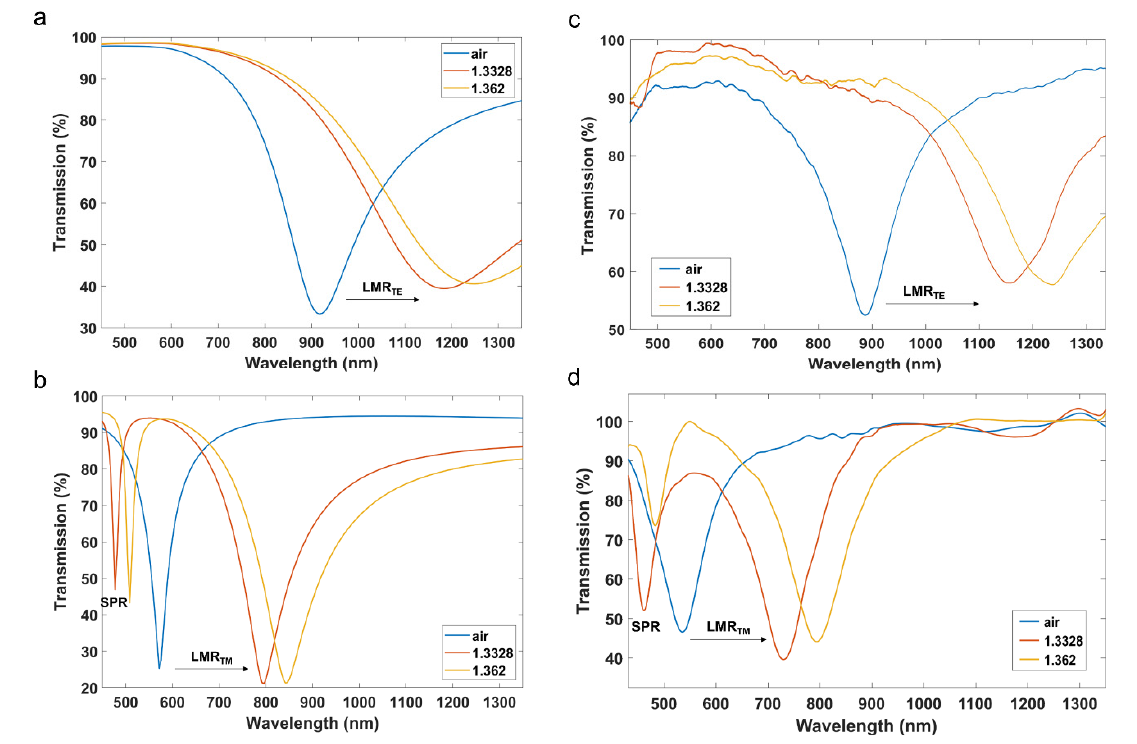
Figure 4. Transmission spectra for three different surrounding medium refractive indices (1, 1.3328 and 1.362): Simulation results at ( a ) TE polarization and ( b ) TM polarization; experimental at ( c ) TE and ( d ) TM polarization.